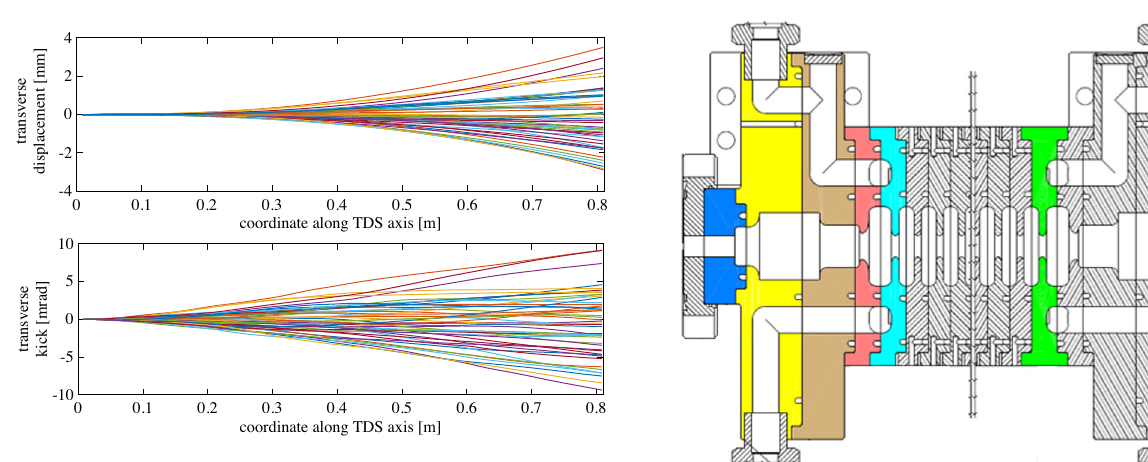
FIG. 15. Effects of the tuning errors on the transverse dis- placement (top) and on the transverse kick (bottom) as a function of the coordinate along the TDS axis.